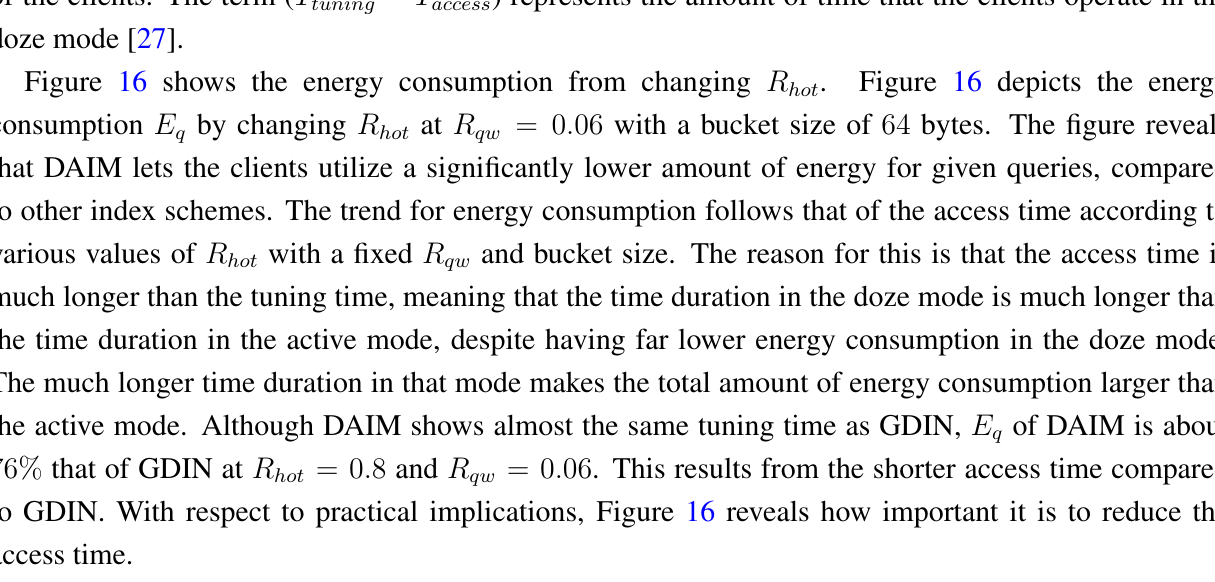
Figure 16. The comparison of the energy consumption over various R